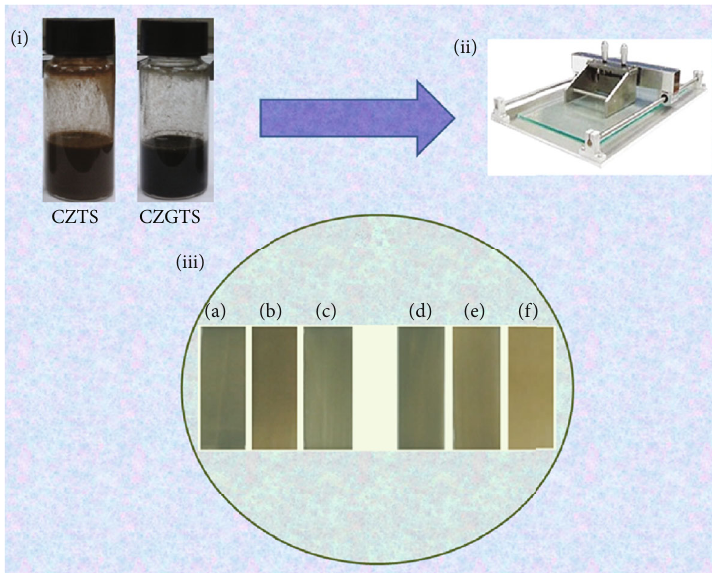
Figure 1: (i) CZTS and CZGTS synthesized solutions; (ii) used doctor blade coater; (iii) (a, b, c). CZTS, CZTS-PVA, and CZTS-DMSO doctor blade-coated sulfurized thin fi lms on SLG soda lime glass substrate; (d, e, f) CZGTS, CZGTS-PVA, and CZGTS-DMSO, doctor blade-coated sulfurized thin fi lms on SLG soda lime glass